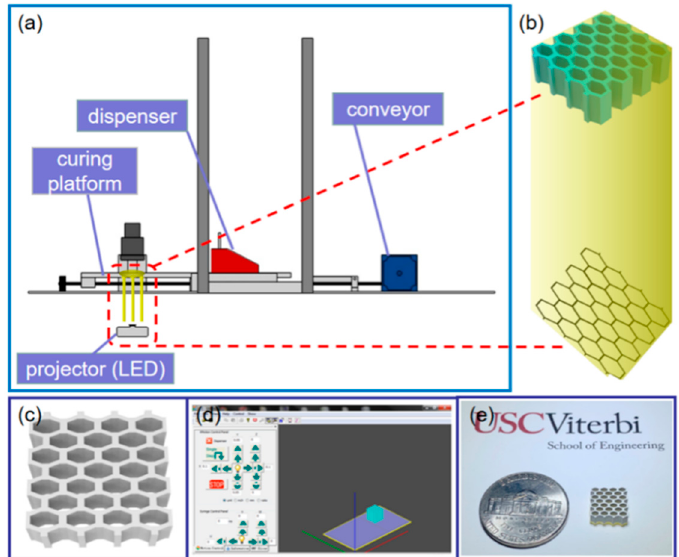
Figure 1. ( a ) Mask-Image-Projection-based Stereolithography (MIP-SL) system to print green parts. ( b ) Sliced 2D pattern of a 3D model projected by a digital light projector. ( c ) Computer-aided design model of the printed sample with honeycomb structure. ( d ) Graphical user interface of the MIP-SL system developed in-house. ( e ) Picture of the green part fabricated using the MIP-SL system.